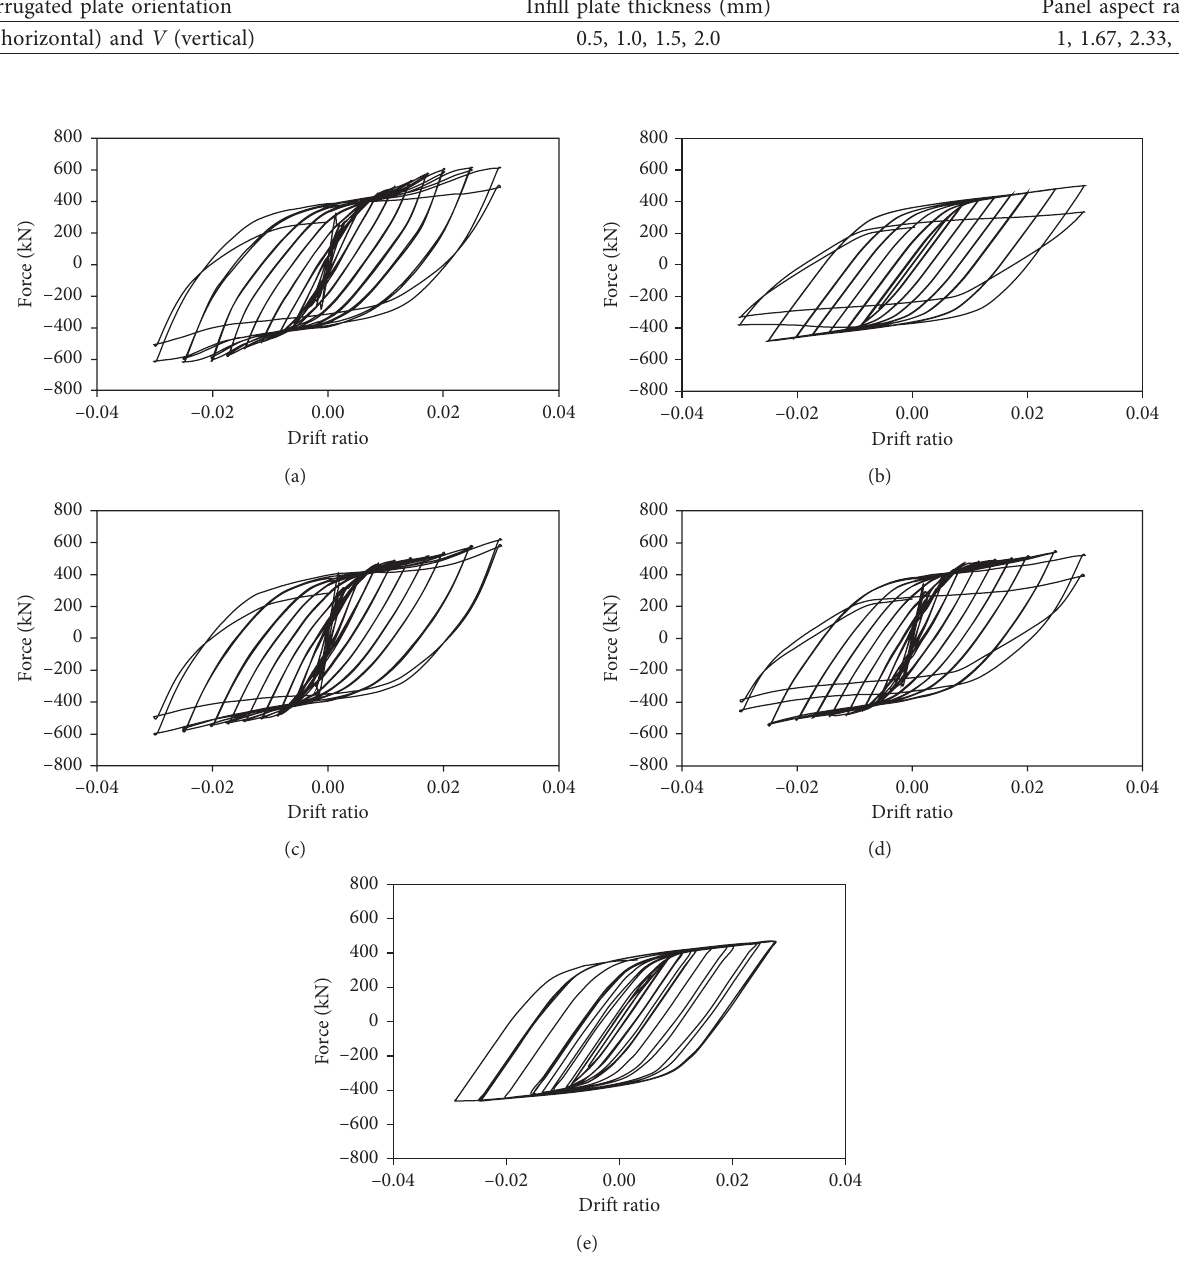
Figure 10: Hysteresis curves of CSPSWs with different configurations. (a) Fully connected H-CSPSW. (b) Beam-only-connected H-CSPSW. (c) Fully connected V-CSPSW. (d) Beam-only-connected V-CSPSW. (e) Bare frame.